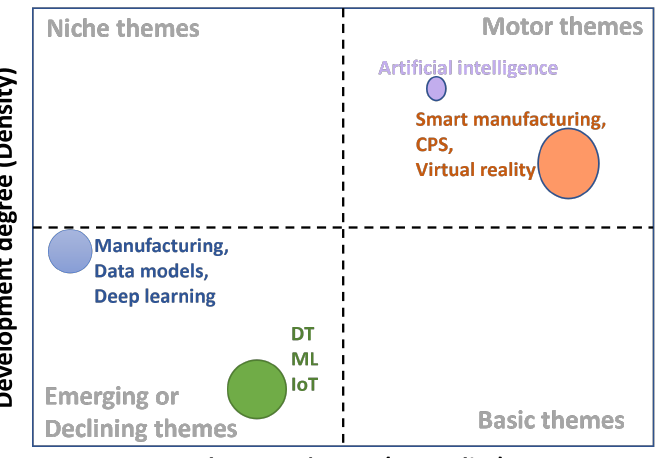
Figure 10. Thematic evolution period 2, 2018–2019. A figure with four quadrants representing specific relevance and development degree. Several motor themes and emerging themes in period 2, 2018–2019.